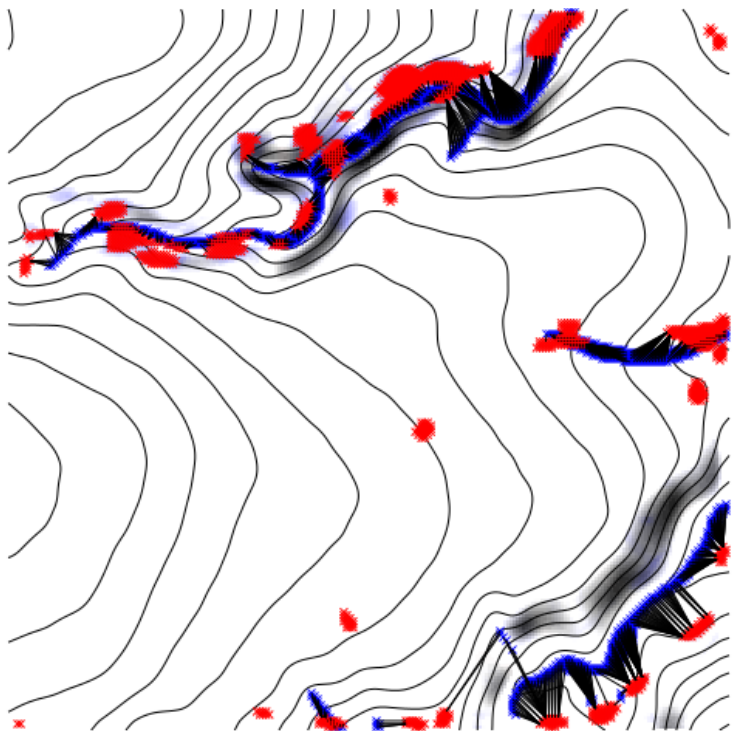
Figure 10: The lines represent the minimum distance between blue points with high concentrated flow from the reference and red points with high concentrated flow from the mean depth of tangibly sculpted